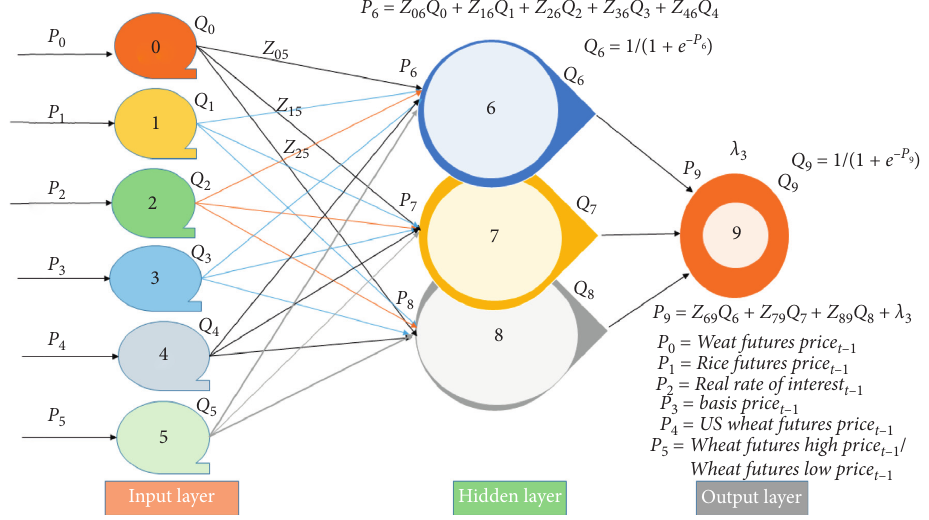
Figure 1: Three-layer artificial neural